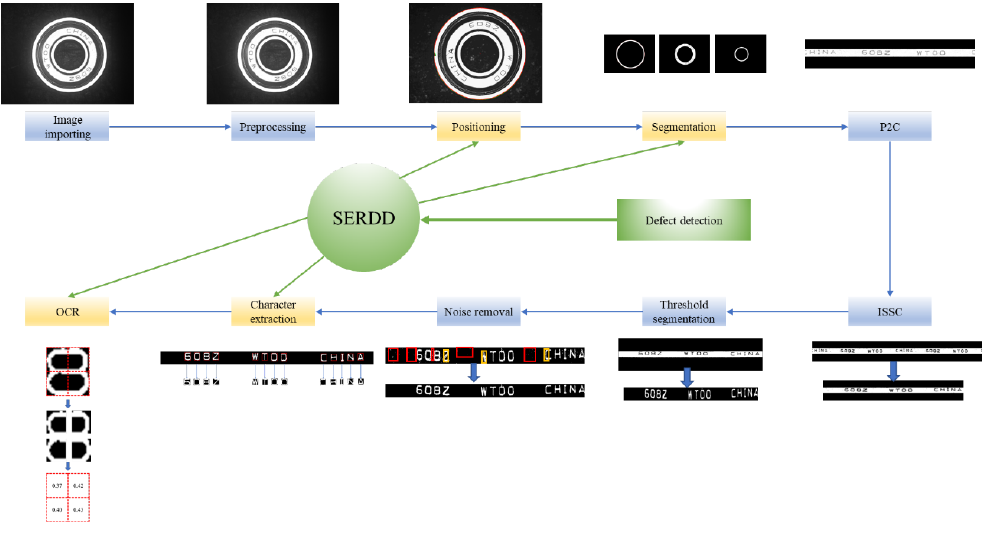
Figure 2. Algorithm flow of